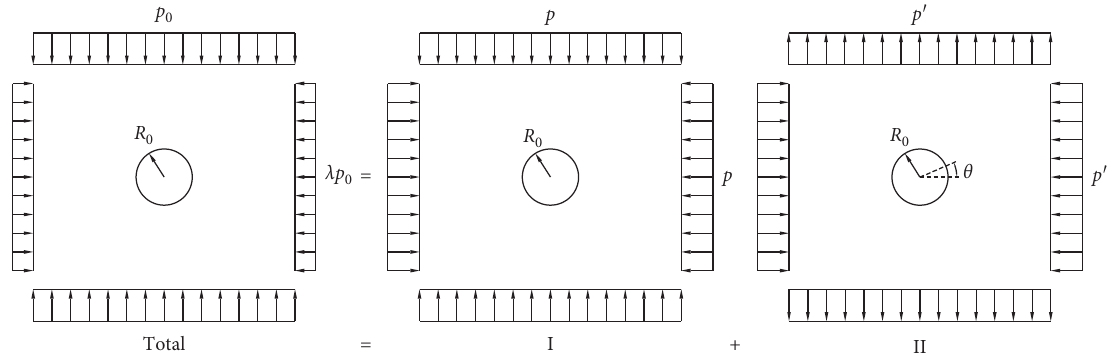
Figure 2: General method of stress state decomposition in tunnel.